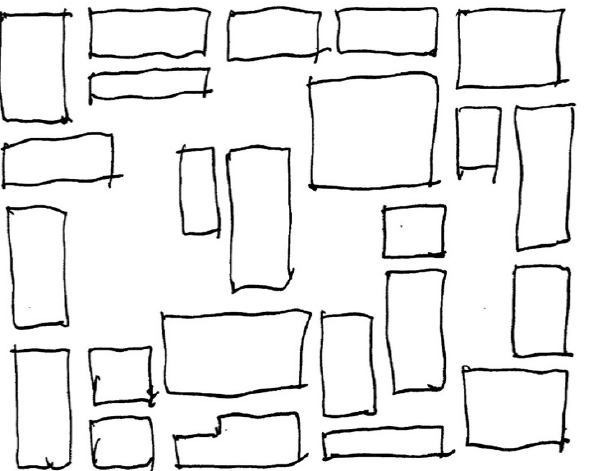
Figure 3. Acceptable plan, despite the formal rectangular grid, includes a connected distribution of urban spaces in a sequence of different sizes. urban spaces in a sequence of different